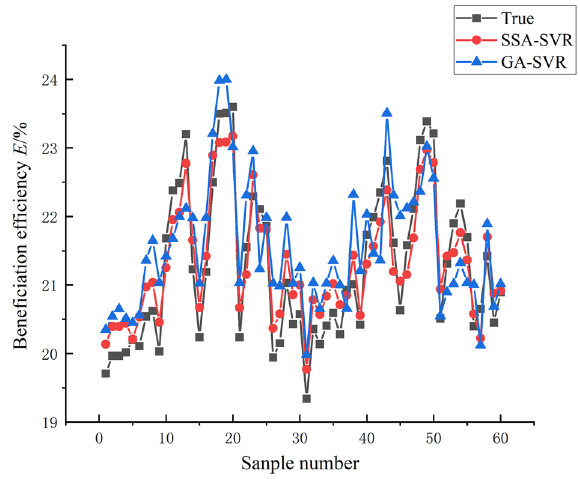
Figure 11. Simulation results of the models on beneficiation efficiency E of shaking table (To supplement the sample data and re-do the training for further verification).